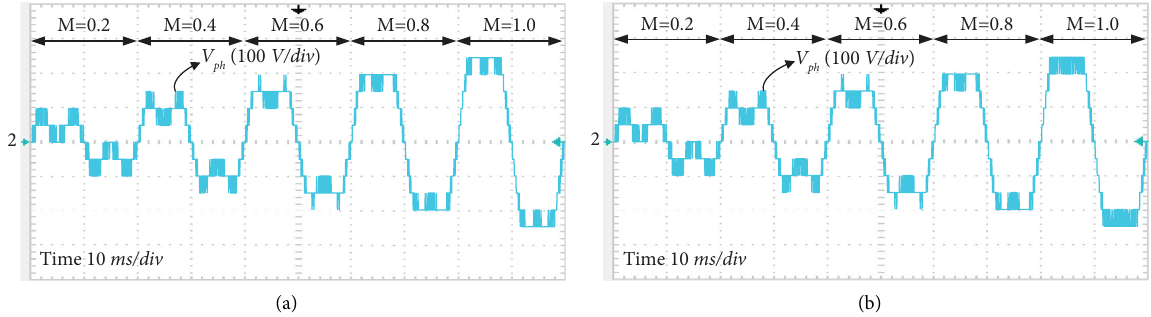
Figure 20: Experimental 11L CHB inverter phase voltage for dynamic values of M . (a) SVPWM-I. (b) SVPWM-II. M=0.2